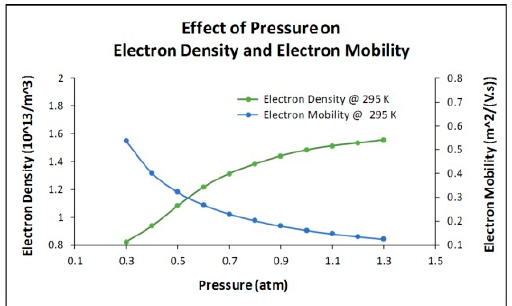
Figure 6. The effect of pressure on electron density and electron mobility at constant temperature of 295